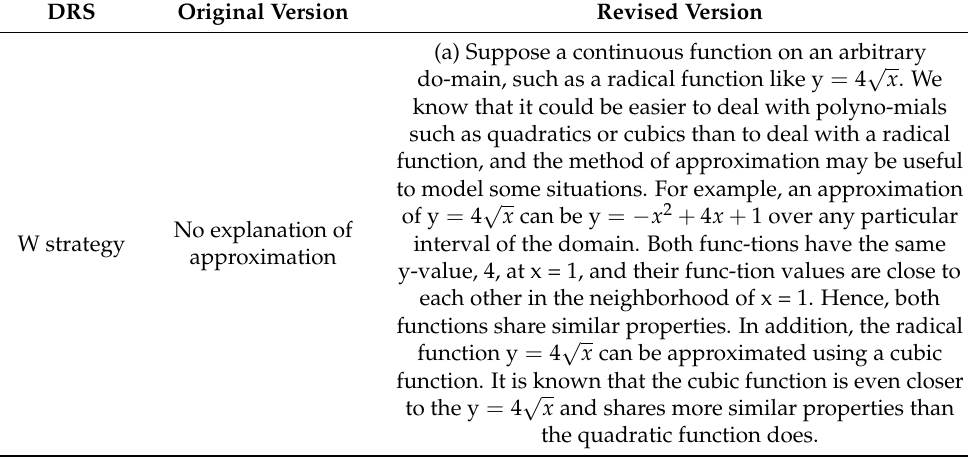
Table 2. W Strategy (Using Words Appropriate for Student Understanding).